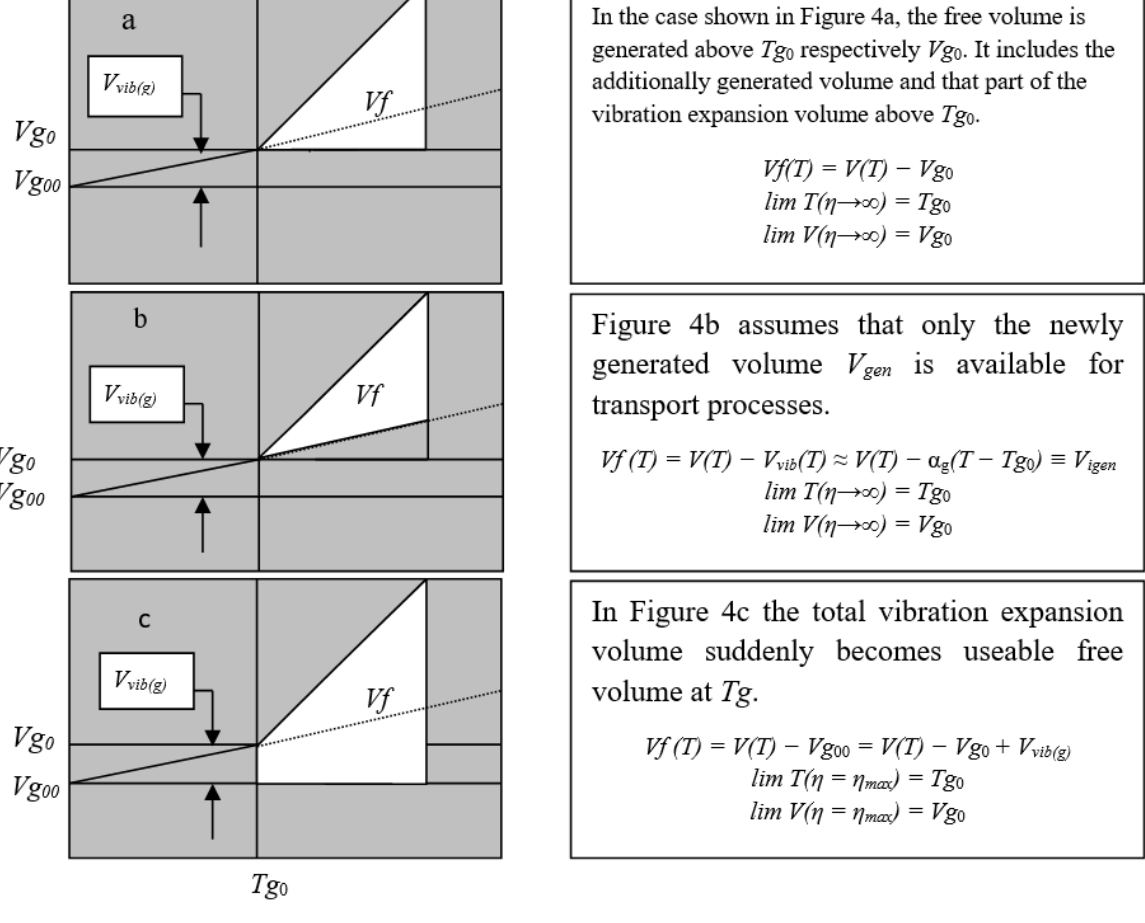
Figure 4. Some possible definitions of free volume ( a – c ).